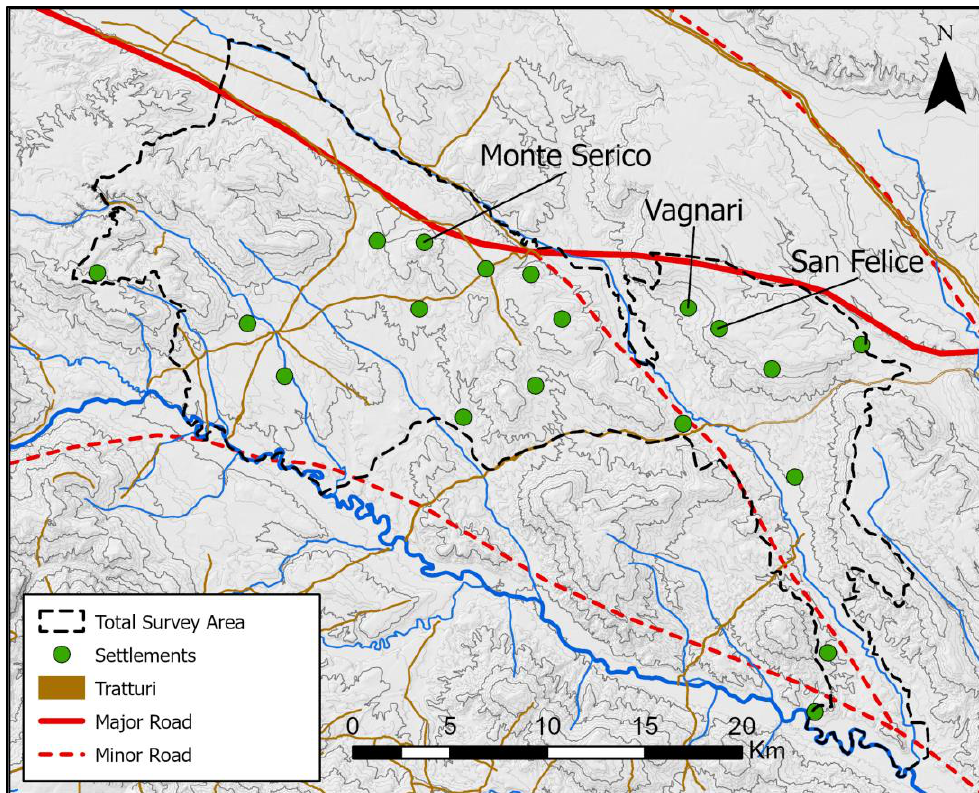
Figure 4. The Basentello Survey Area showing interaction between Roman roads, tratturi , water- courses, and agglomerated settlements (c. AD 200 – 1000) identified during surveys.